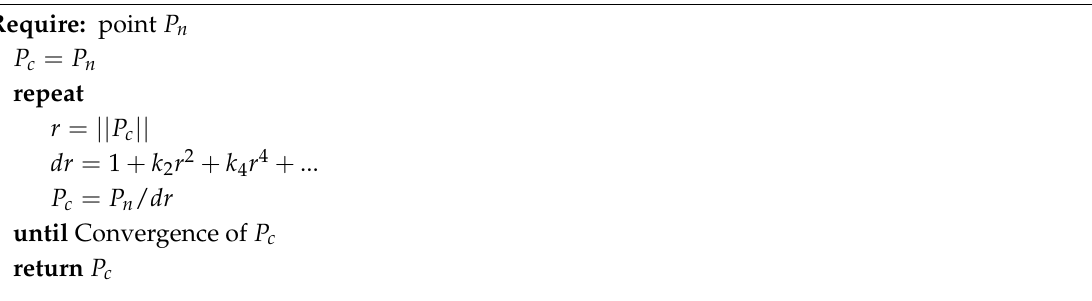
Algorithm 1 Iterative algorithm to compute the inverse